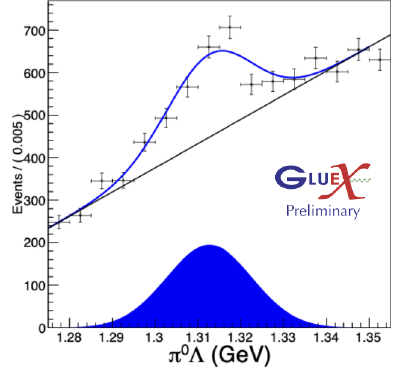
Figure 8. Preliminary invariant mass spec- trum of the π 0 Λ subsystem in the reac- Ξ 0 → K + { π + π − } π 0 Λ → tion γ p → K + K 0 s K + { π + π − } γγπ − p . The Ξ 0 (1315) can be identified as a peak at the expected mass on top of some moderate background.